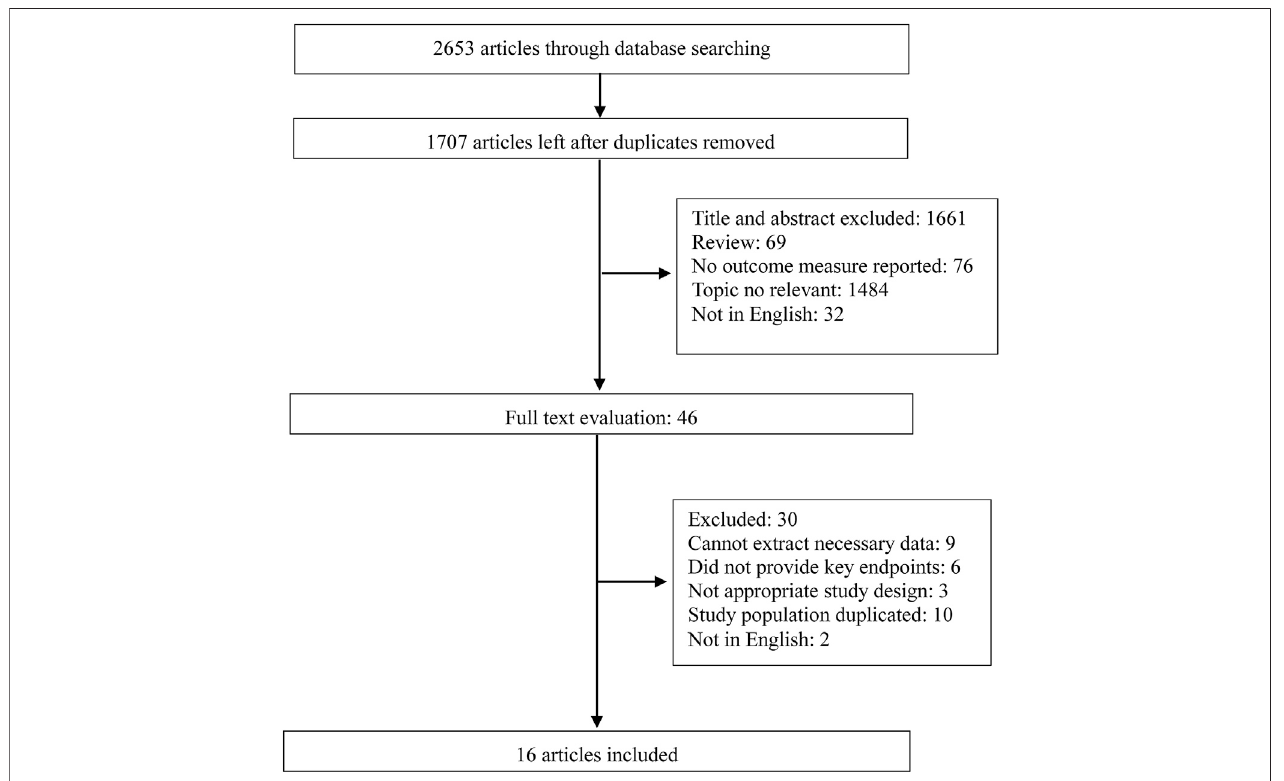
FIGURE 1 | Flowchart of the study